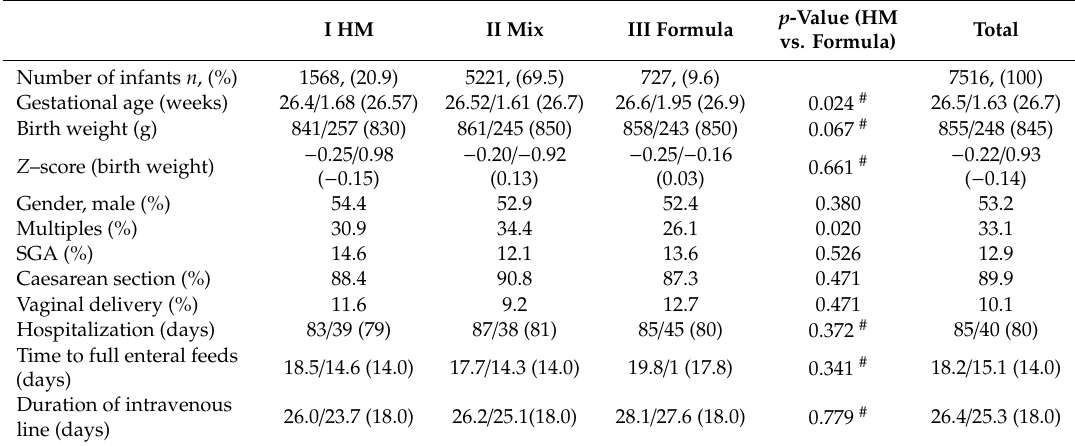
Table 3. Clinical characteristics of the GNN cohort stratified to type of milk feeding.